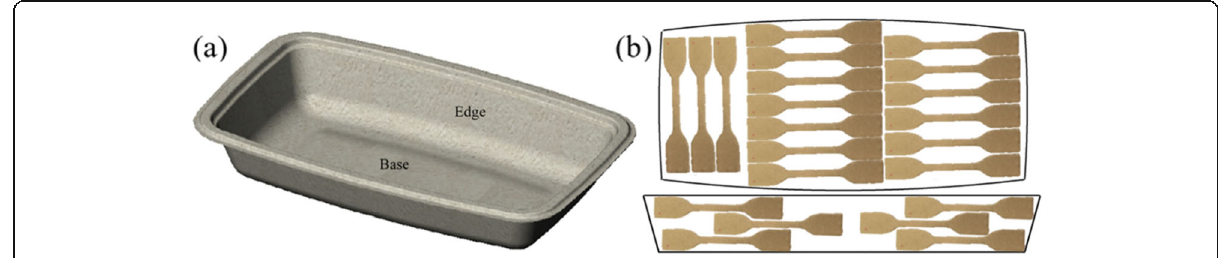
Fig. 2 a 3D model of the food tray used for the study, b sample cutting zones used for the base and edge of the food